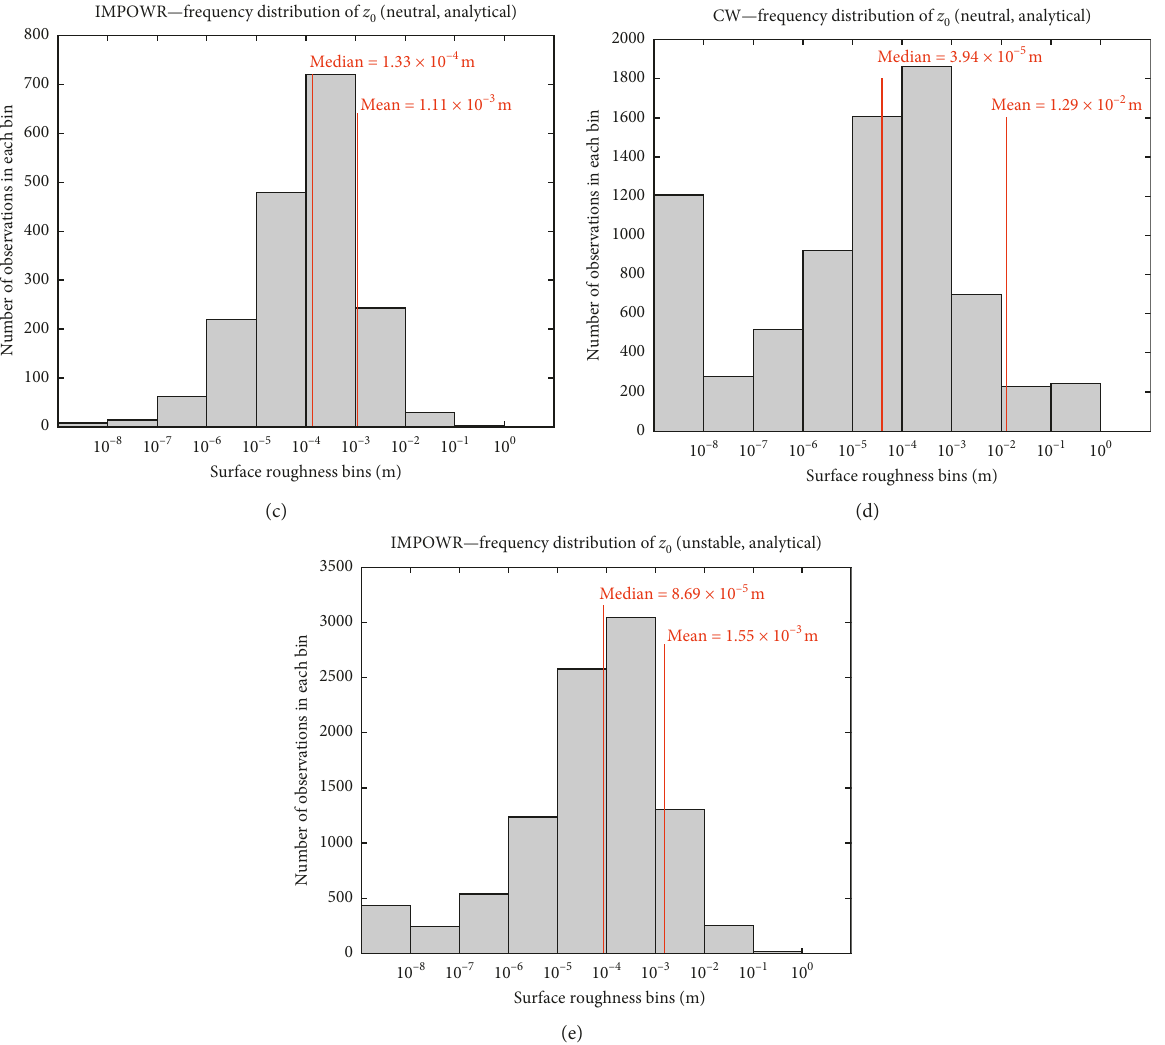
Figure 3: Frequency distribution of surface roughness length during the 2013–2014 IMPOWR campaign using two sonic anemometers located at 12m AMSL (left) and during the 2003–2007 historical Cape Wind campaign (right) for (a, b) stable, (c, d) neutral, and (e, f) unstable cases. The mean and median z 0 are displayed on each figure. The x -axis is logarithmic and the y -axis has different maxima in each